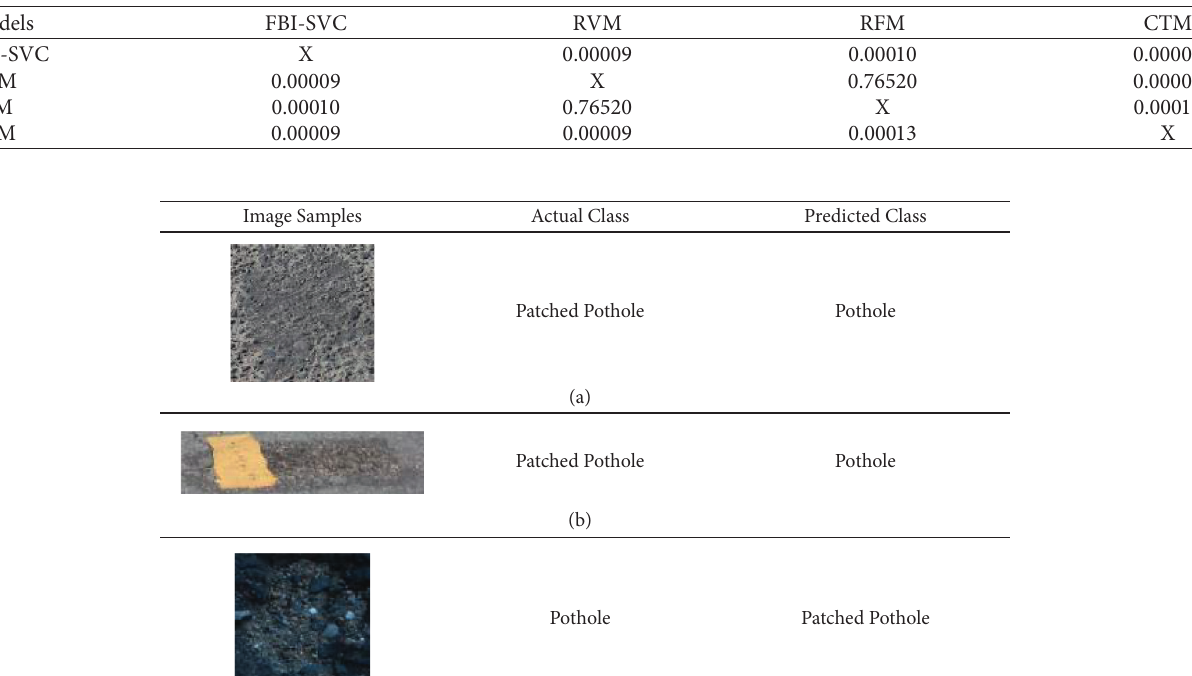
Table 4: p values obtained from Wilcoxon signed-rank test results with AUC index.